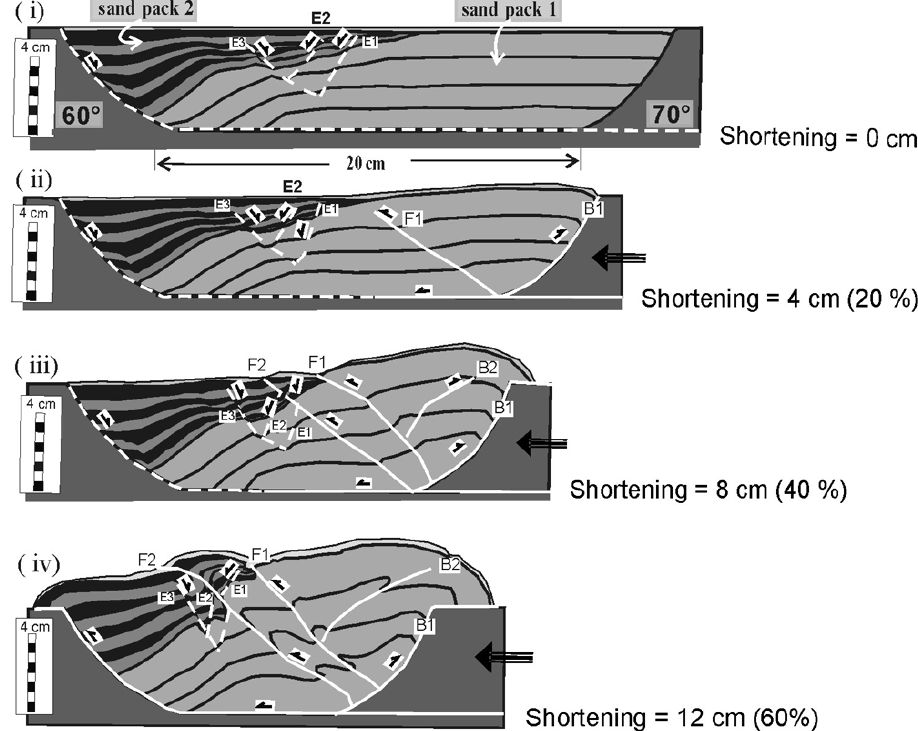
Fig. 9 – (i-iv) Sequential line drawings of inversion steps of photographs that were taken through the transparent sidewalls of model 6 ( α = 70 ◦ and β = 60 ◦ ). E1-E3 are structures formed during extensional steps; F1 and F2 are forethrusts, and B1 and B2, backthrusts. Dashed and continuous lines represent extensional and contractional structures, respectively.